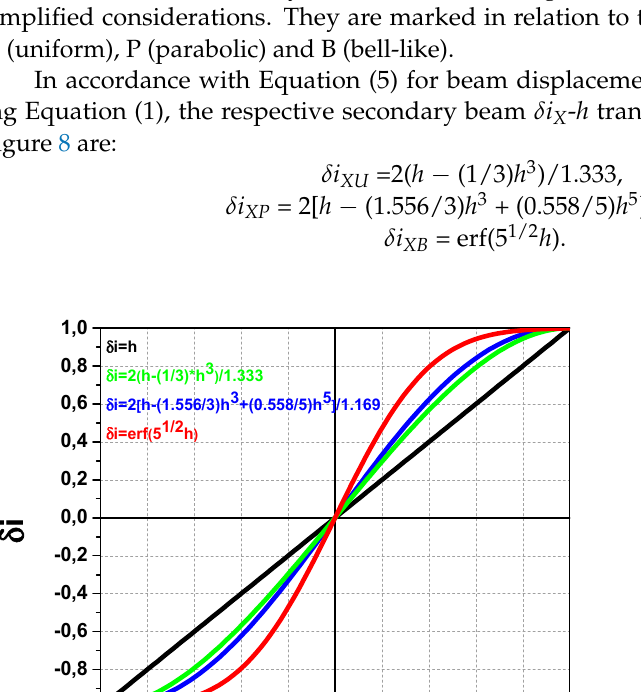
Figure 7. Schematic of the 90 ◦ CEA arrangement on ISTTOK.